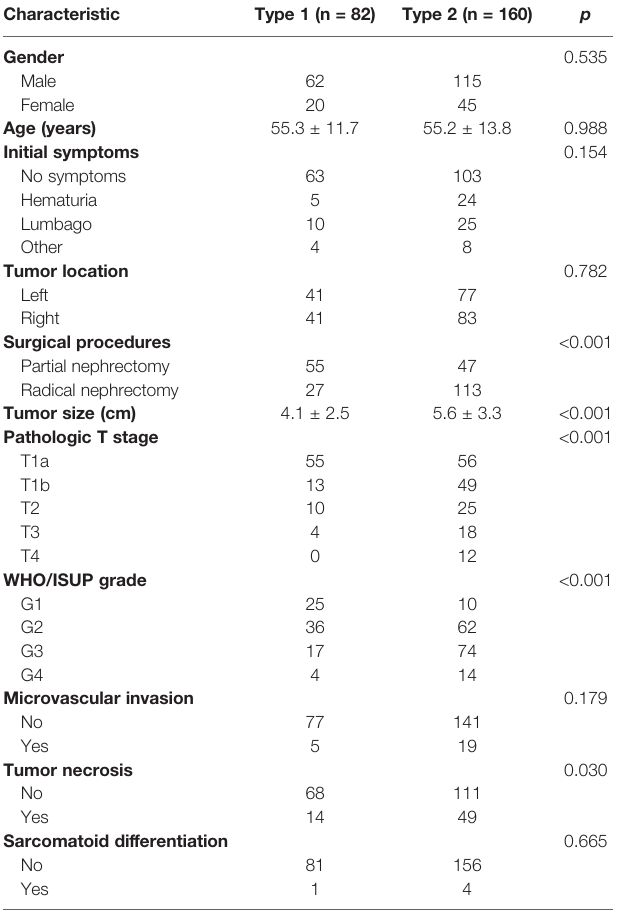
TABLE 1 | Comparison of clinicopathological characteristics between type 1 and type 2 PRCC.